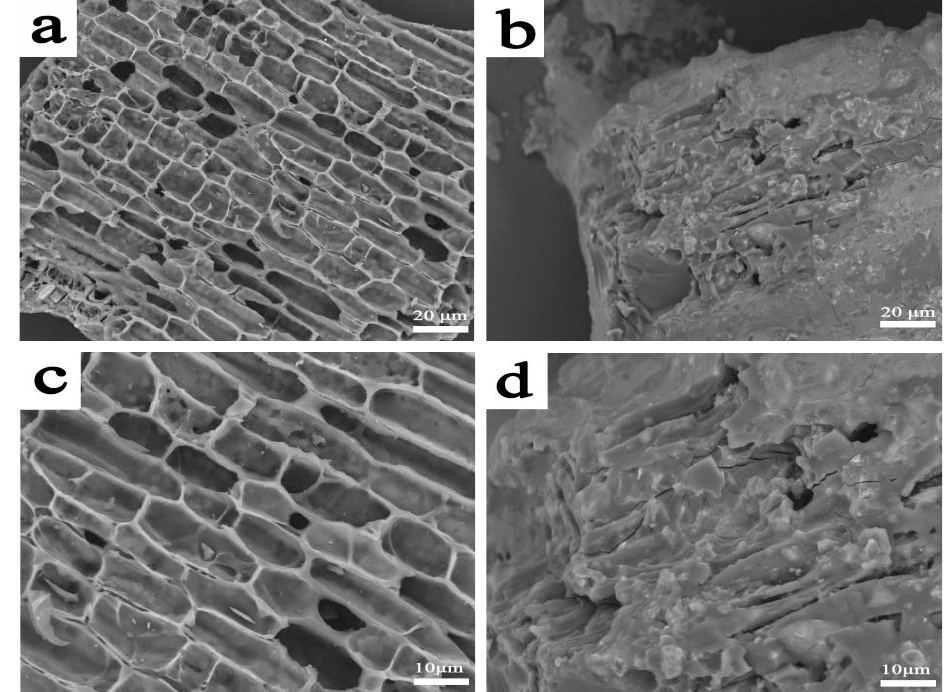
Figure 4. Topography of BC ( a , c ) and mBC ( b , d ) with different magnifications.